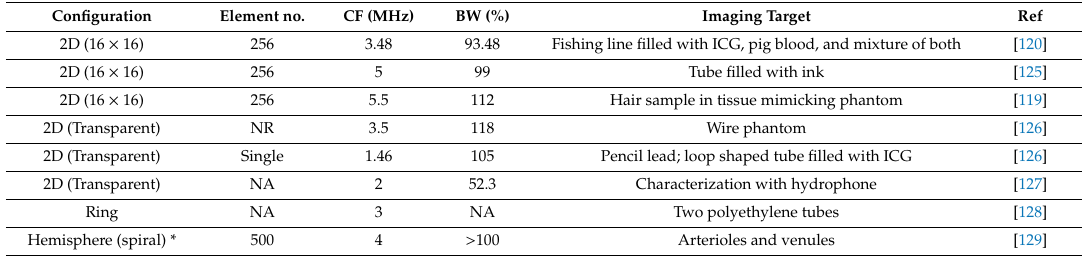
Table 3. Di ff erent configurations of CMUT that have been used in photoacoustic imaging applications. Configuration Element no. CF (MHz) BW (%) Imaging Target Ref 2D (16 × 16) 256 3.48 93.48 Fishing line filled with ICG, pig blood, and mixture of both [120] 2D (16 × 16) 256 Tube filled with ink [125] Hair sample in tissue mimicking phantom Single 1.46 105 Pencil lead; loop shaped tube filled with ICG [126] NA 2 52.3 Characterization with hydrophone [127] Two polyethylene tubes [128] Arterioles and